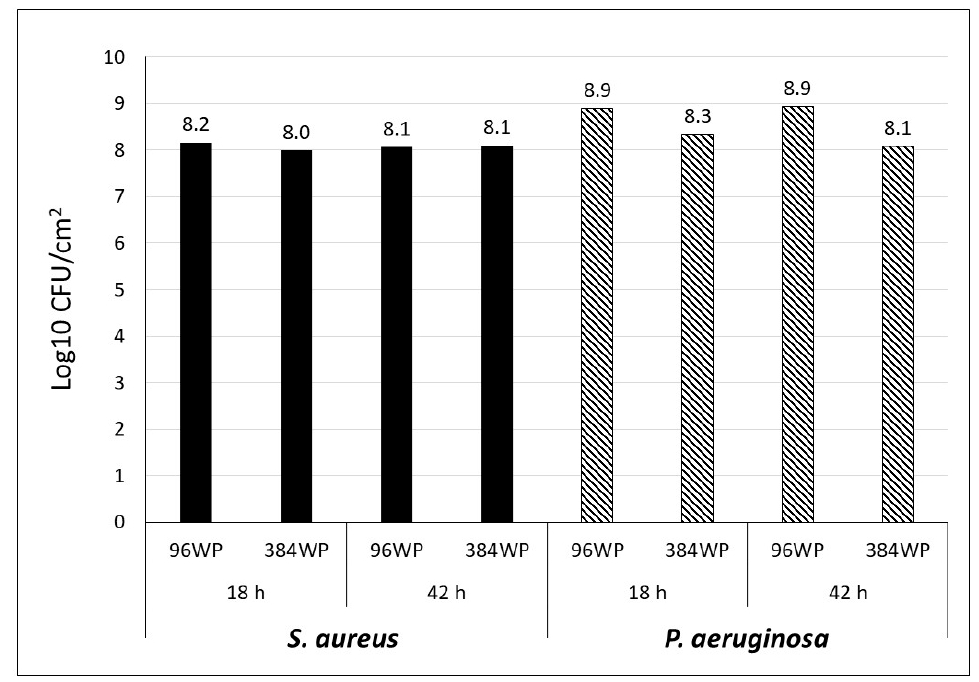
Figure 6. Log10 of the CFUs per cm 2 of S. aureus (black) and P. aeruginosa (striped) biofilms grown in 96WP or 384WP for 18 h or 42 h. The data represents the average of 16–22 biofilms (technical replicates) from 2–5 independent biological replica